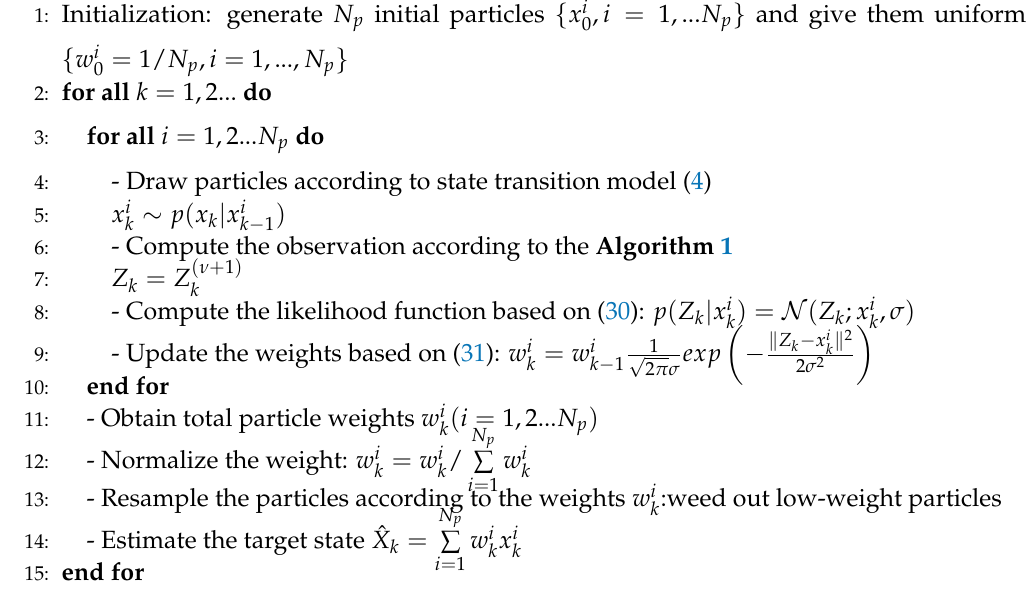
Algorithm 2 Support vector learning-based particle filter